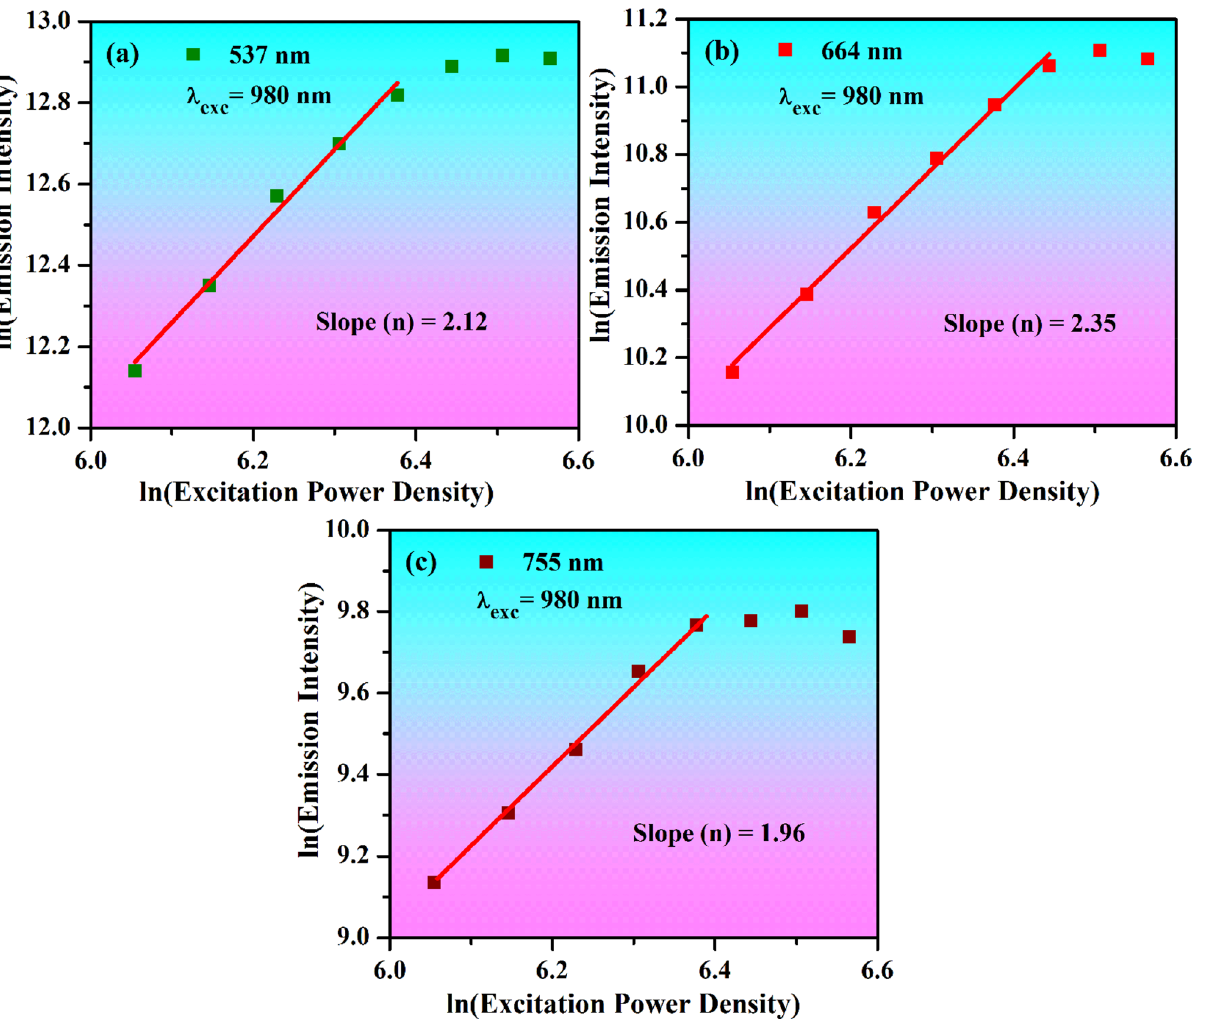
Figure 8. The dual logarithmic plots between the emission intensity ~ excitation power density (W/cm 2 ) of ( a ) green; ( b ) red and ( c ) NIR emissions for the Ho 3+ /Yb 3+ doped